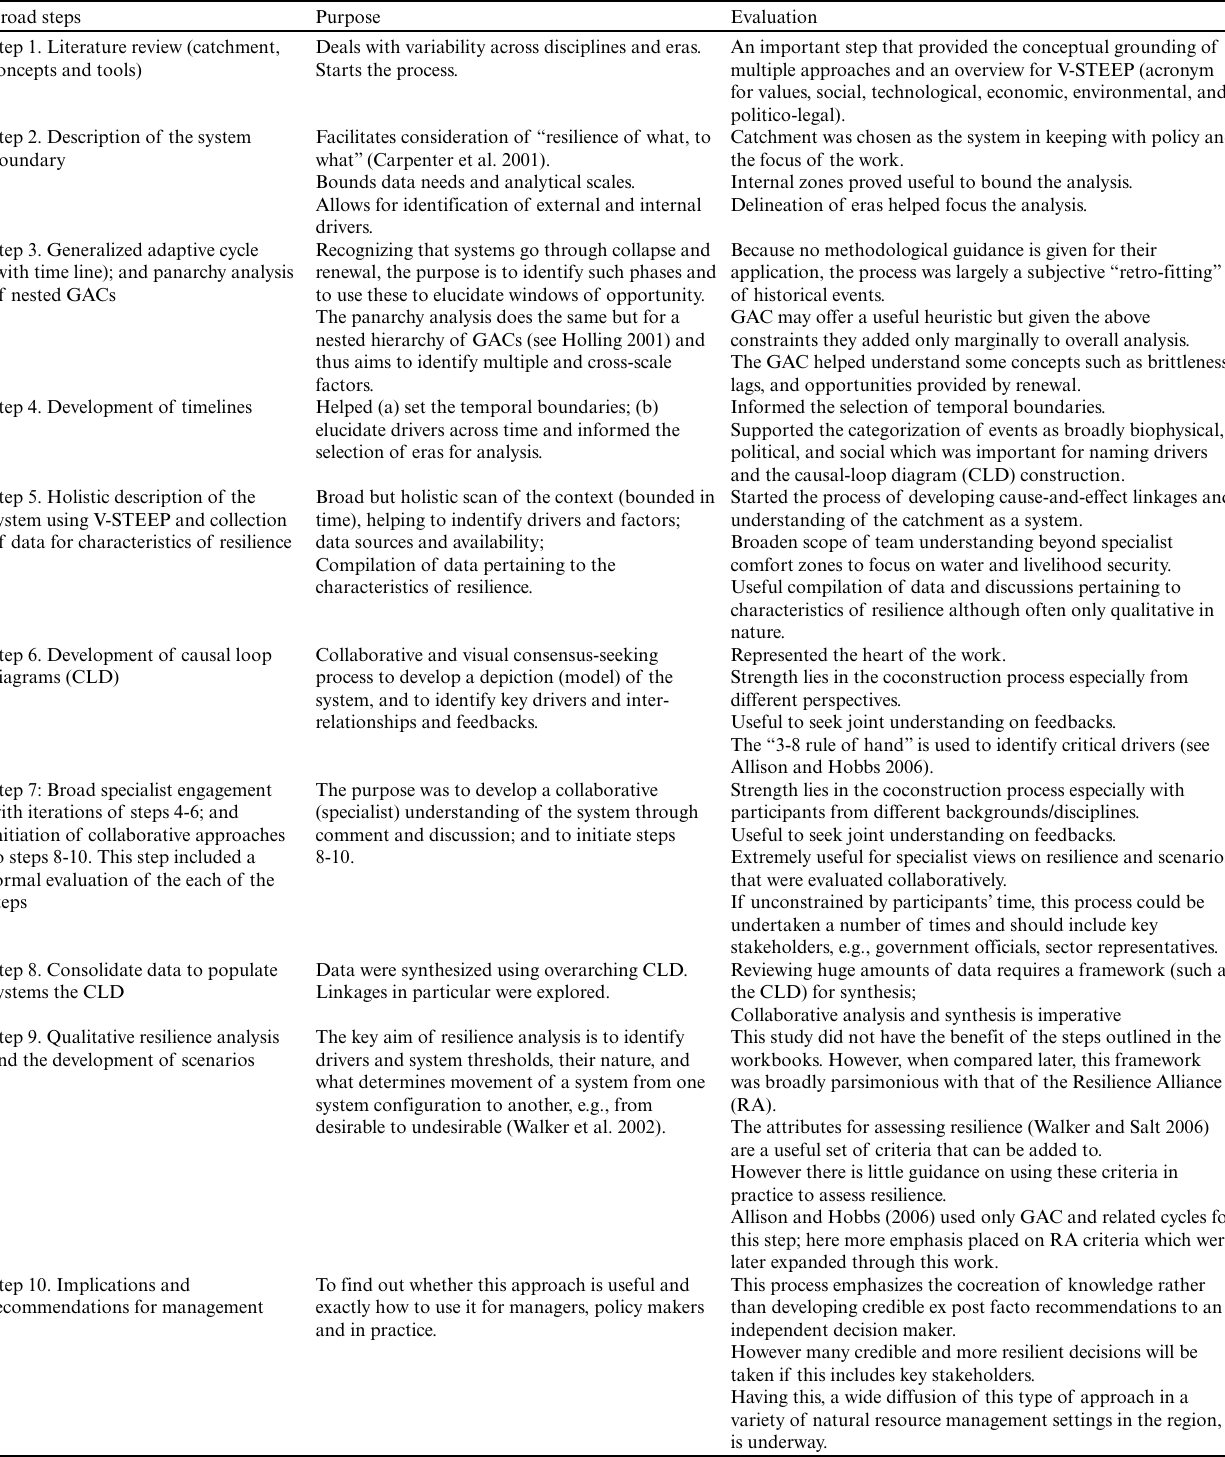
Table 1 . Summary of the broad steps comprising the integrative framework, the purpose of each, and an evaluation of its application in this